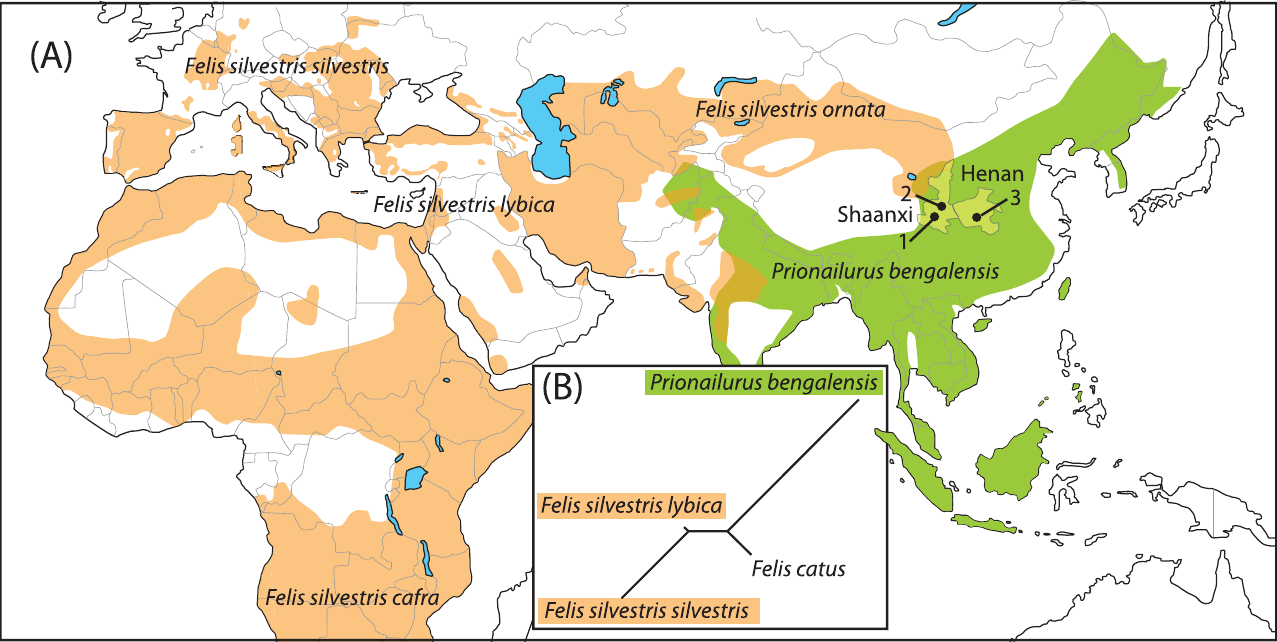
Fig 1. Modern distribution of wild felid species, archaeological site location and mandible shape relationship between modern wild felid species and domestic cat. (A) , Modern Old World distribution of the different wild cat subspecies ( Felis silvestris ) and the leopard cat ( Prionailurus bengalensis ), and location of the three Middle-Late Neolithic sites of the Shaanxi and Henan Provinces (China) analyzed in this paper: 1, Quanhucun, 2, Wuzhuangguoliang, 3, Xiawanggang (Redrawn from [http://maps.iucnredlist.org/map.html?id=60354712] and [http://maps.iucnredlist.org/map.html?id=18146] under a CC BY license, with permission from IUCN Red List of Threatened Species; S1 Text.; CAD I. Carr è re); (B) , Phenotypic relationship (unrooted neighbour joining tree) built on mandible shape distances between modern domestic cat ( F . catus ), leopard cat ( P . bengalensis ) and the two relevant sub-species of wild cat ( F . s . silvestris; F . s . lybica ) from our